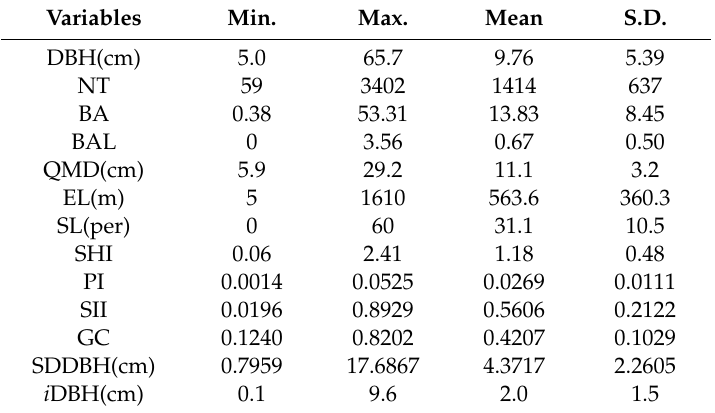
Table 1. Descriptive statistics for the candidate variables used in the model. Variables Min. Max.